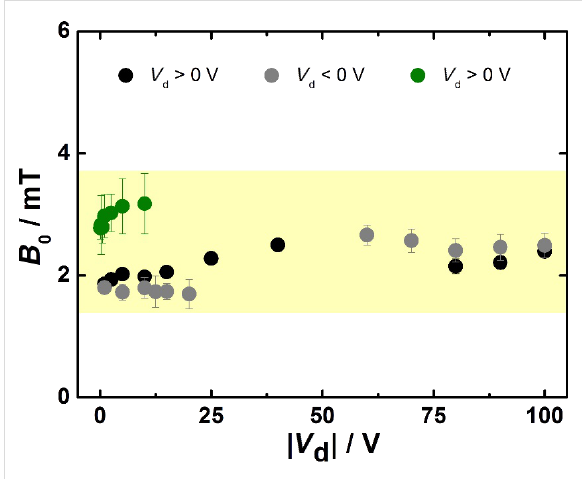
Figure 6: Voltage dependence of the line shape width B 0 . The values of B 0 were obtained from fitting the data with the non-Lorentzian fit